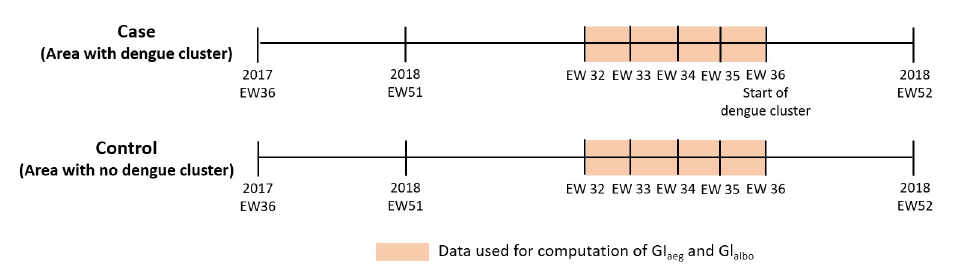
Fig 3. Illustration on the computation of mean GI aeg and GI albo in cases (area with dengue cluster) and controls (area with no dengue cluster).